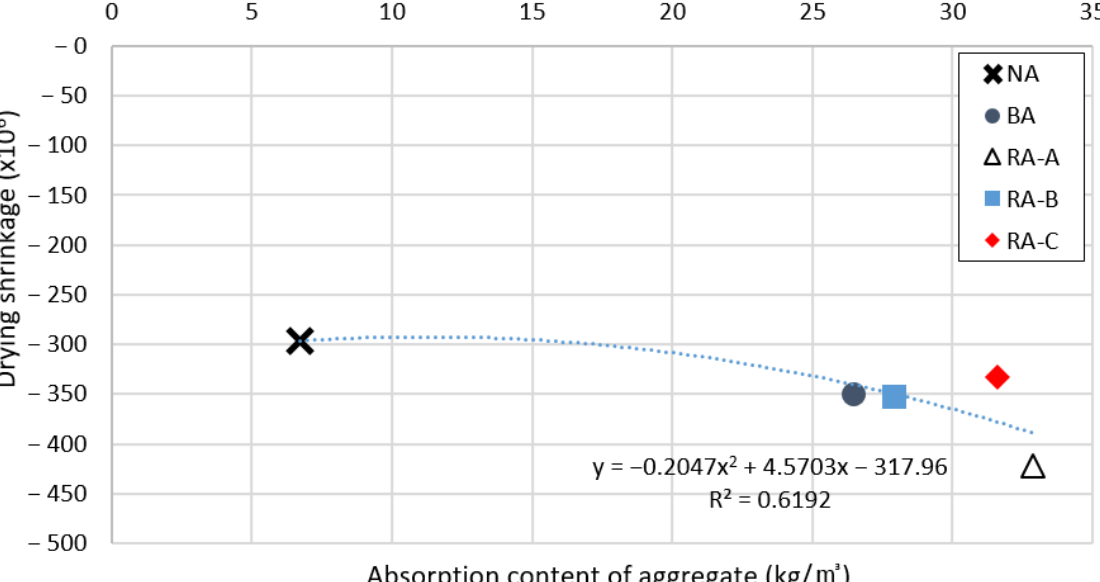
Figure 12. Drying shrinkage of concrete specimens according to absorption content of aggregate.